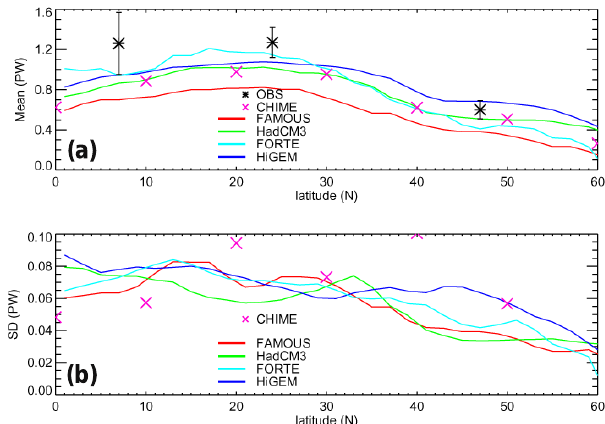
Fig. 11. Zonal profile of (a) mean annual ocean meridional heat transport (PW) and (b) variability of annual ocean meridional heat transport in the North Atlantic. The observational estimate of heat transport is from Ganachaud and Wunsch (2003). CHIME data is only available in 10 ◦ latitude